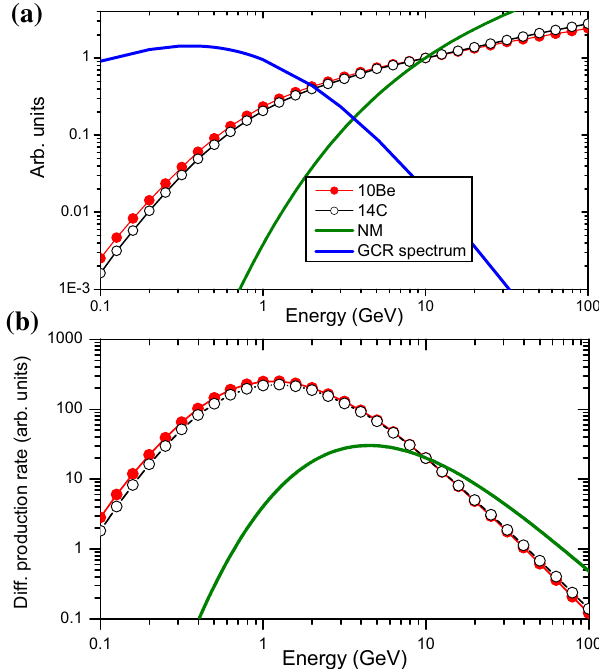
Fig. 9 Differential production yield functions of cosmogenic isotopes and ground-based neutron monitors as a function of cosmic-ray energy. a Columnar yield functions of 10 Be (Poluianov et al. 2016), 14 C (Poluianov et al. 2016), polar neutron monitor (Mishev et al. 2013) as well as the energy spectrum of galactic cosmic protons for medium modulation ( φ = 550 MV). b The differential production rate for 10